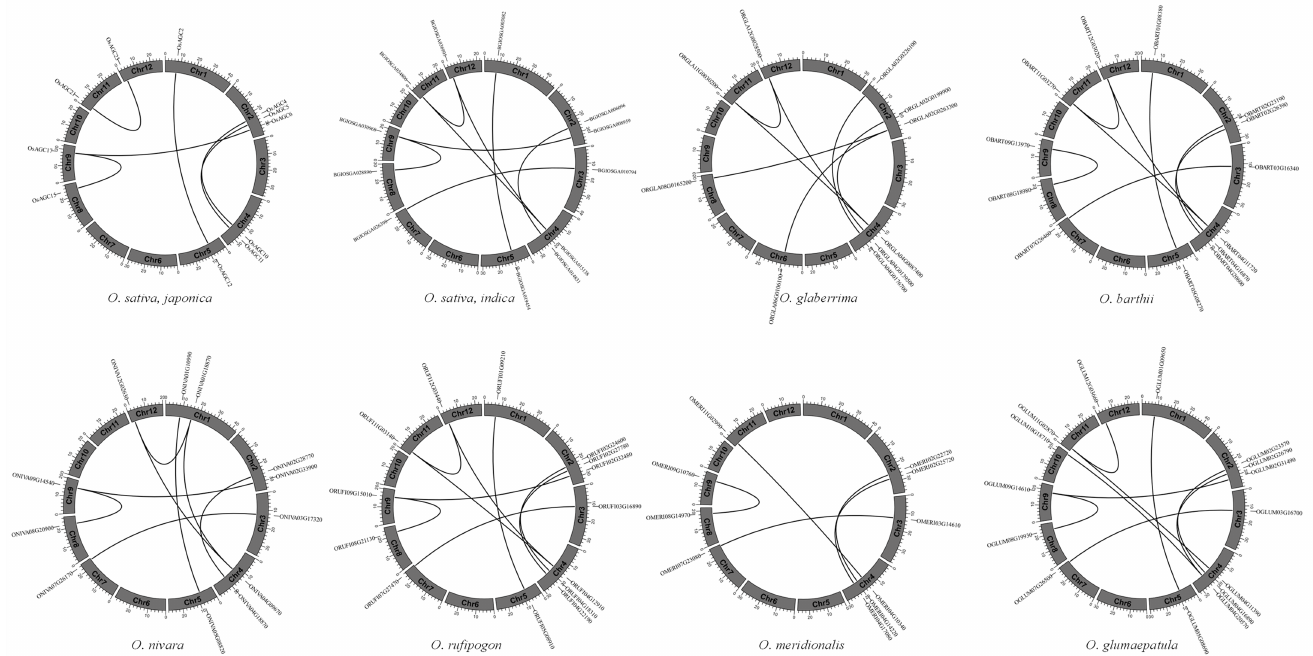
Figure 3. Collinearity analysis of AGCs in Oryza